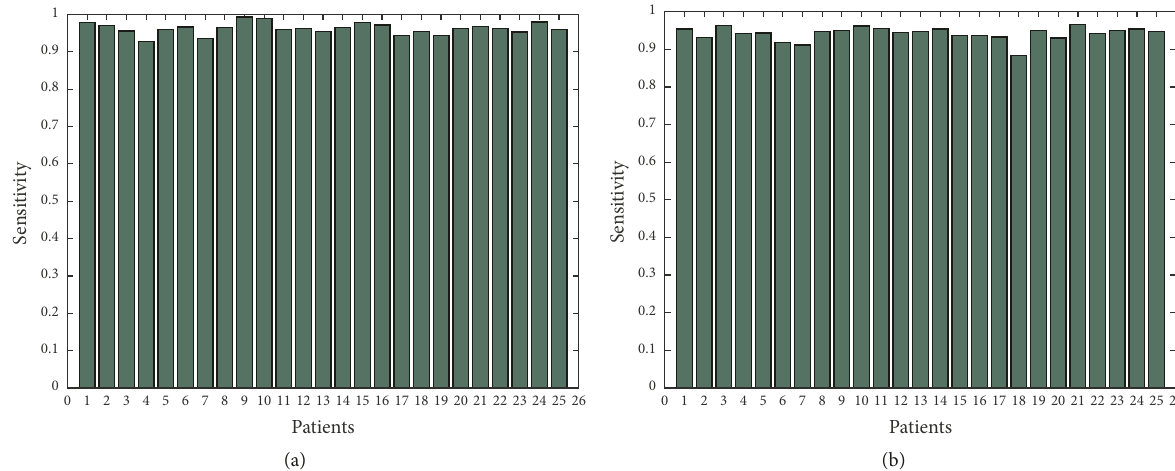
Figure 11: Sensitivity in thermal images for 50 patients; (a) 25 with high-grade taken from BRATS 2012; (b) 25 with low-grade taken from BRATS 2013.